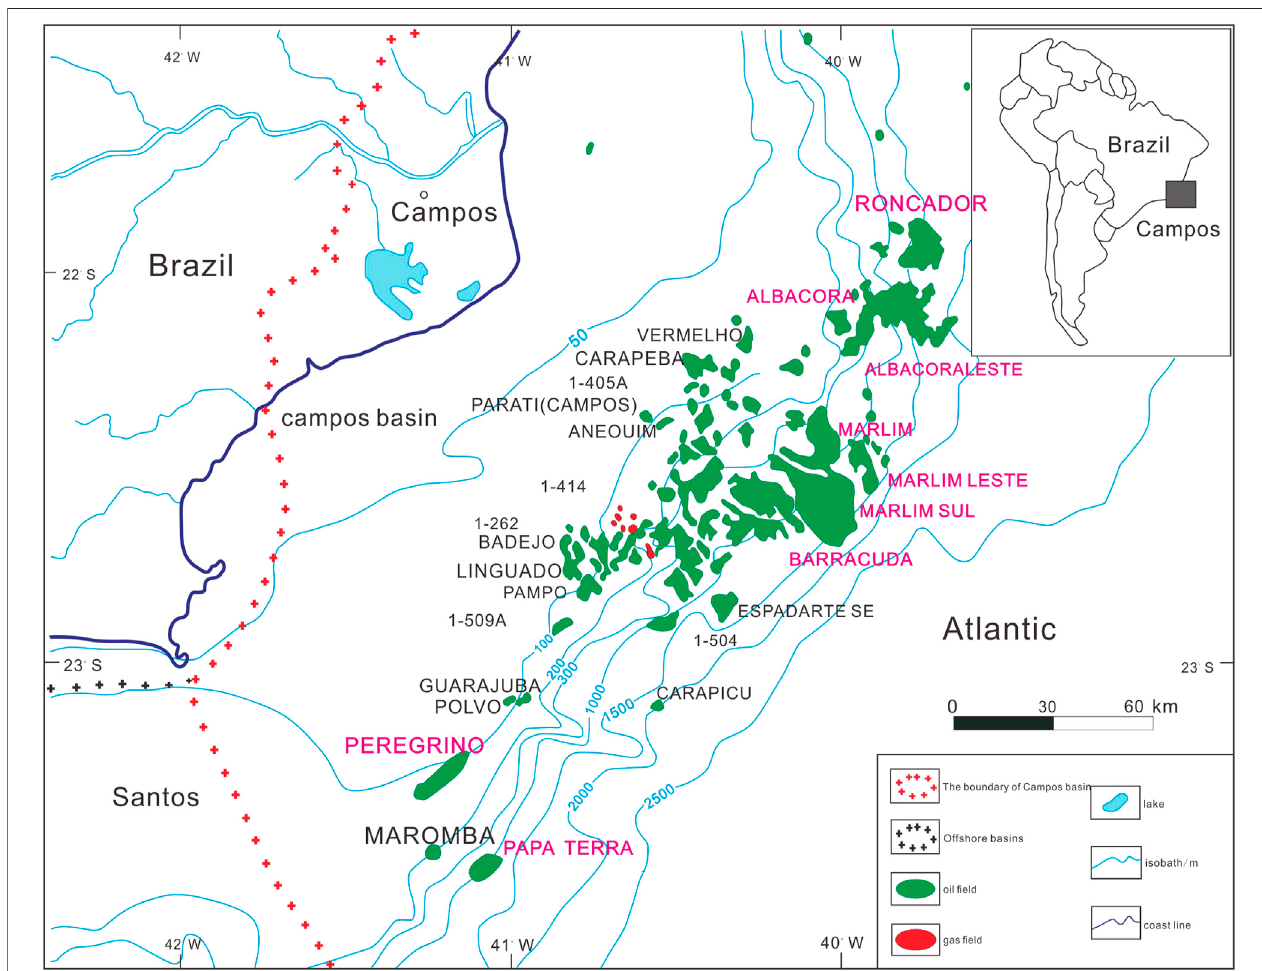
FIGURE 1 | Location of the Campos Basin and the distribution of the main oil and gas fi elds.